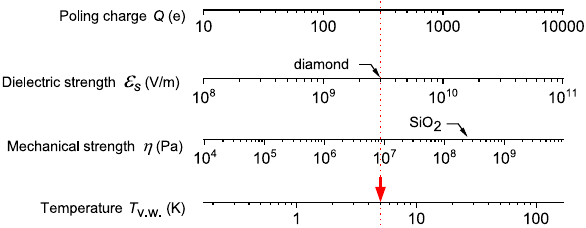
Figure 5. Mutual relations between the poling charge Q , the dielectric strength E s ( Q ) (Eq. (22)) and mechanical strength η( Q ) (Eq. (24)), and the temperature T ( Q ) (Eq. (21)) for octupoling at the cell’s center in the very weak 12 nm. Black arrows design maximal accessible values (dielectric and 60 nm and r s poling regime for R = = mechanical strengths) of the poling setup. The red arrow points at maximal accessible temperature T v.w. resulting from the restrictions imposed by E s